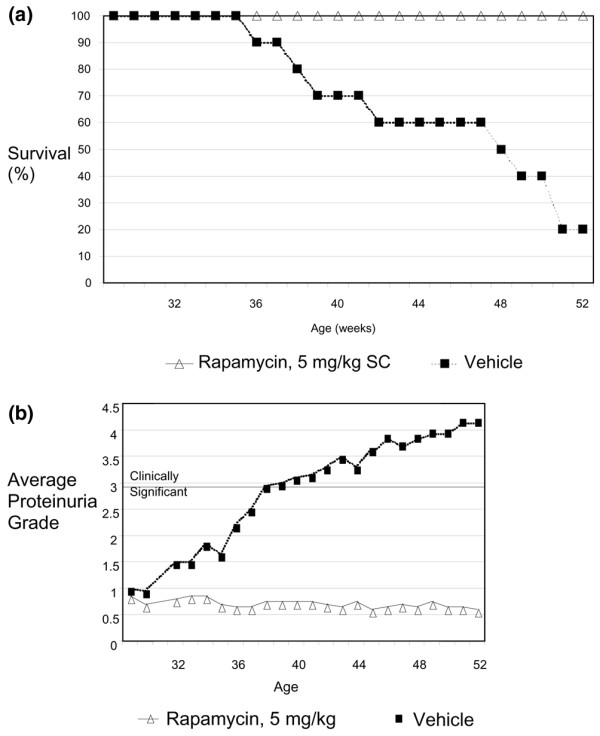
Proteinuria and survival measurements. (a) Survival and (b) proteinuria were measured weekly starting at 29 weeks of age (n = 10). Grade 0.5 proteinuria = 'trace'; grade 1 = about 30 mg/dL; grade 2 = about 100 mg/dL; grade 3 = about 300 mg/dL, a clinically significant level; grade 4 = more than 2000 mg/dL; grade 5 = death.